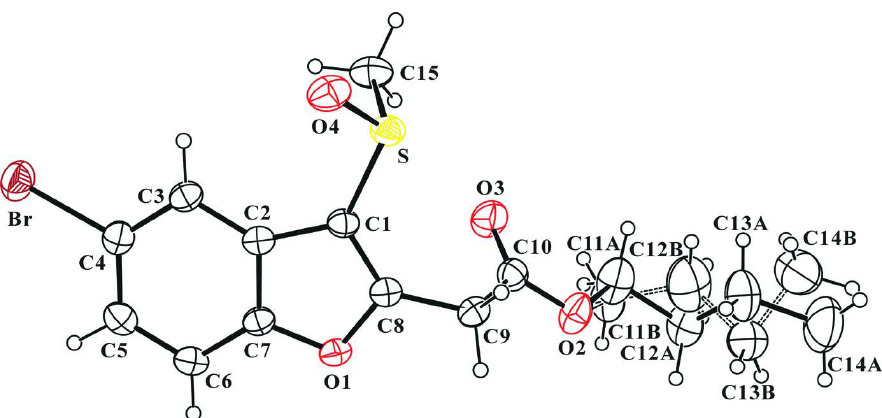
Figure 1 The molecular structure of (I), showing displacement ellipsoids drawn at the 30% probability level. The butyl group is disordered over two positions with the major component having a site occupancy = 0.720 (8).